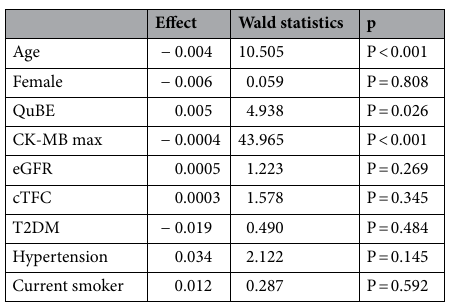
Table 3. Predictors of left ventricle ejection fraction (analysis of covariance). CK-MB muscle-brain creatine kinase isoenzyme, QuBE quantitative myocardial blush evaluator, T2DM type 2 diabetes mellitus, eGFR estimated glomerular filtration rate.